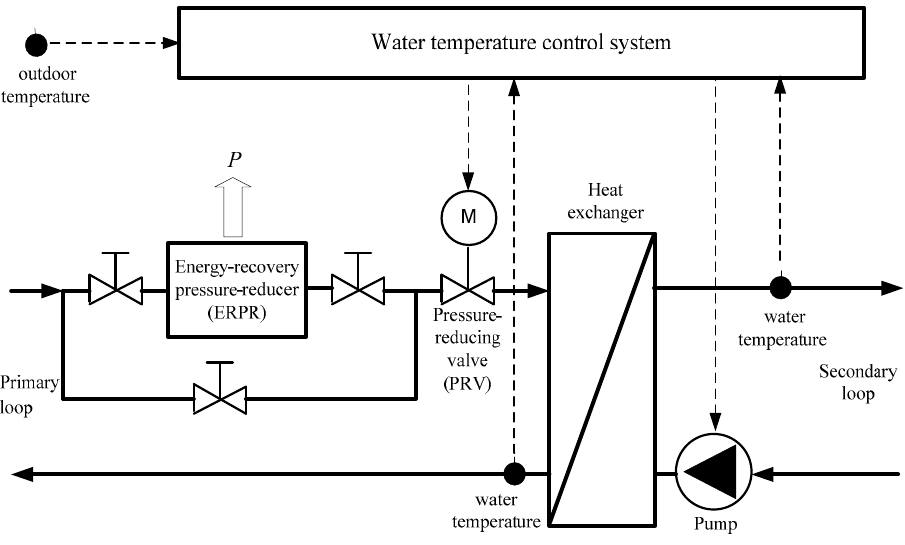
Figure 2. Block diagram of the district heating substation with ERPR.